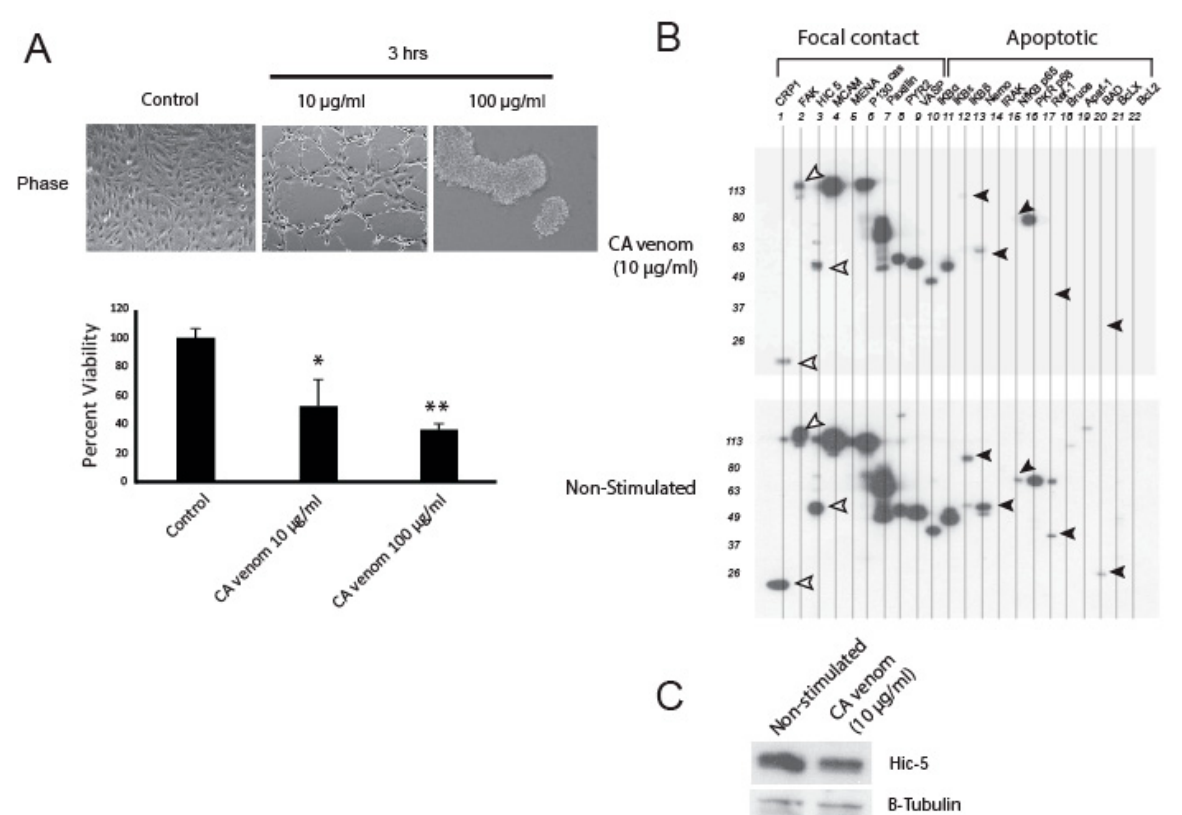
Figure 1. CA venom induces loss of substrate contact and decreased viability in HUVEC. ( A ) Phase contrast images of HUVEC monolayers stimulated with 10 or 100 µg/ml CA venom for 3 h. MTS assay demonstrates significant decrease in HUVEC viability after 3 h stimulation with 10 or 100 µg/ml CA venom. * p < 0.05 vs. control ** p < 0.01 vs. non-stimulated control (n = 3). ( B ) Multi-Western blotting of focal contact and apoptotic proteins. HUVEC monolayers stimulated with CA venom (10 µg/mL) for 3 h. Focal contact proteins indicated by white arrow and apoptotic proteins (black arrows). Control included non-stimulated lysates. ( C ) Conventional Western blo tt ing of Hic- 5 and β -tubulin loading control.